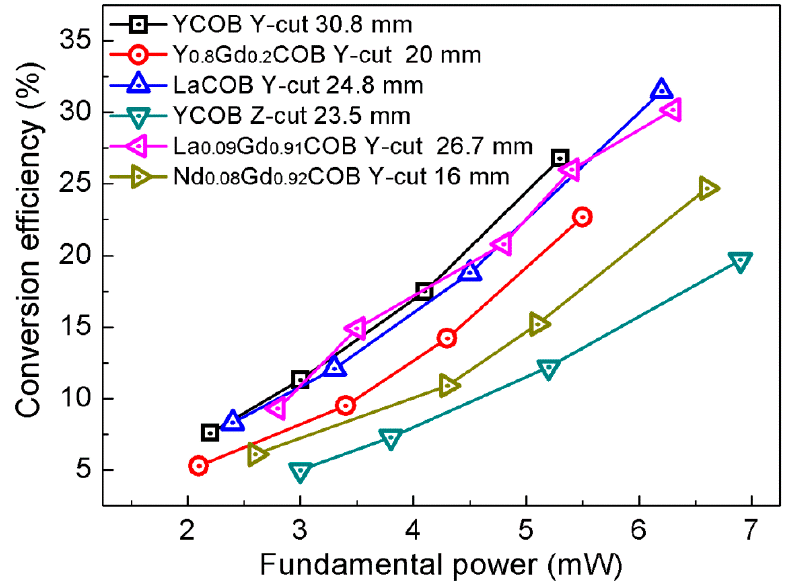
Figure 5. Type-I A-NCPM SHG conversion efficiency of RE1 x RE2 1 − x COB crystals for the OPO